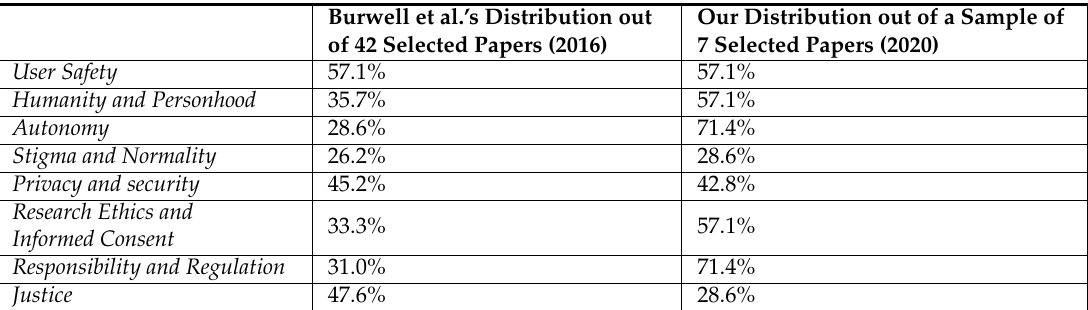
Table 1. The distribution of overarching themes of BCI